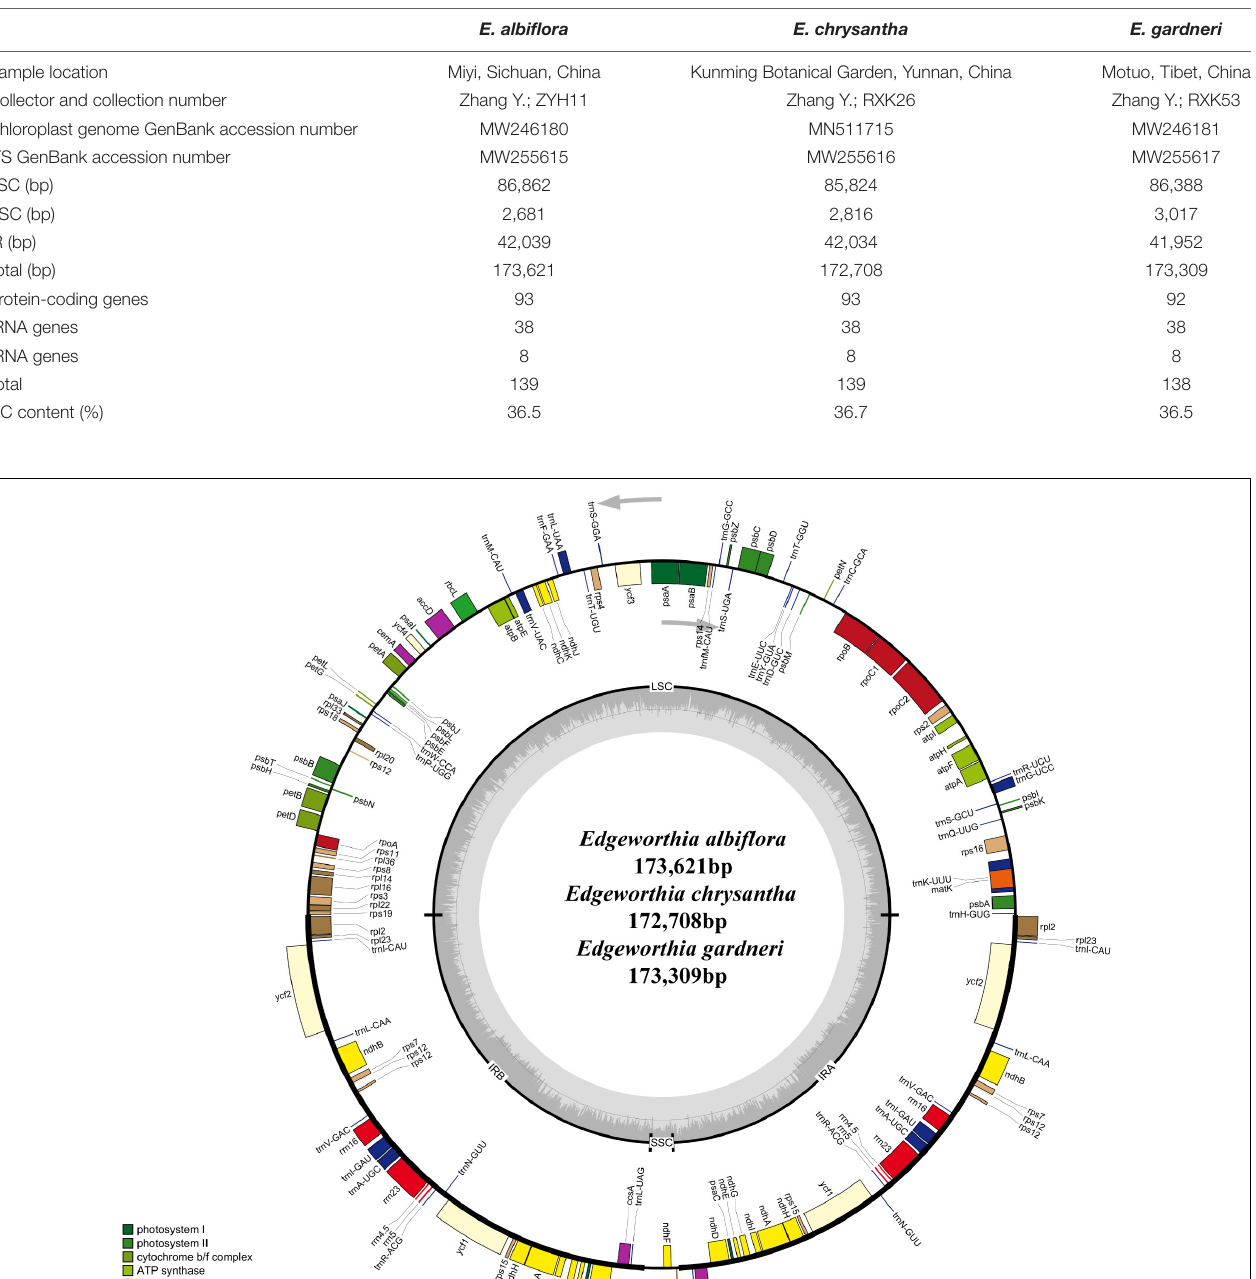
TABLE 1 | Basic characteristics of chloroplast genomes in three species of Edgeworthia .